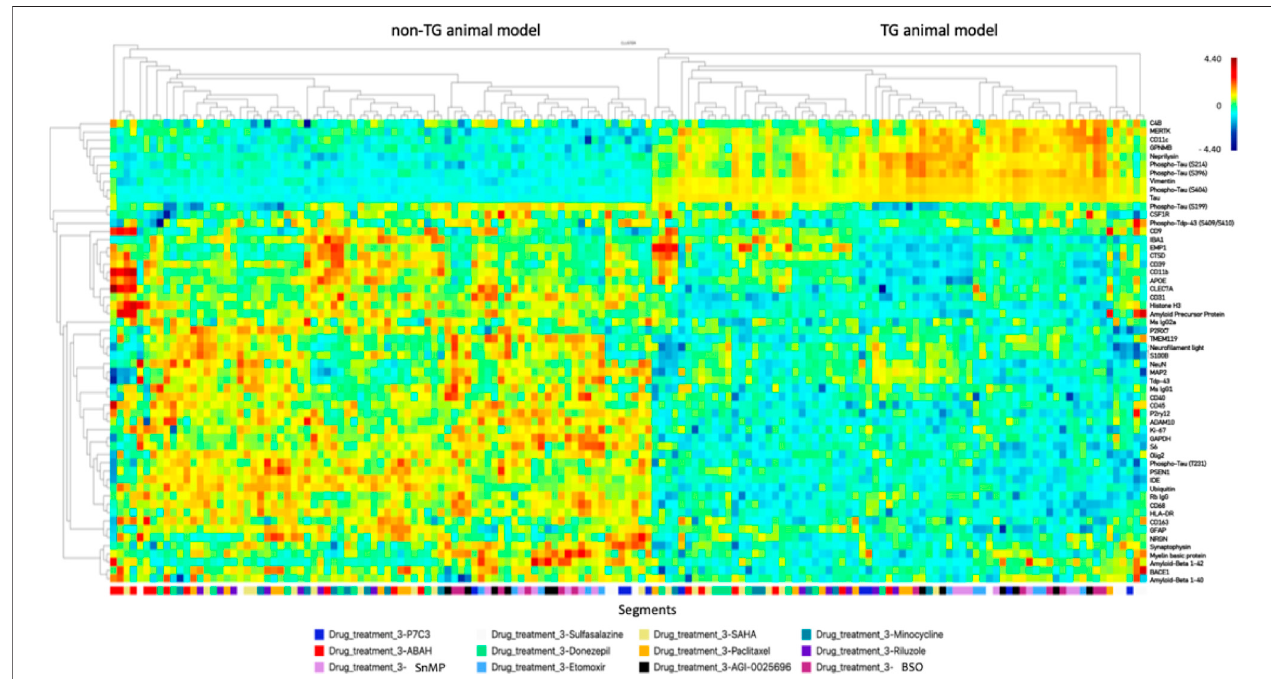
FIGURE 6 | Unsupervised clustering map of drug responses to 12 agents as measured by 56 protein markers, for TG and non-TG mouse models at t = 7 days. Scale is shown in log2 difference.